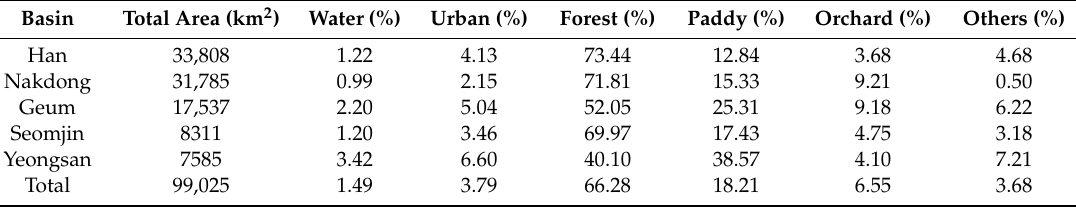
Figure 1. Characteristics of the study area: ( a ) topography of the catchment and locations of 5 major basins, 6 dam sites, and 60 Automated Surface Observing System (ASOS) stations; ( b ) land cover / land use map. (Source: digital elevation map (DEM) and land cover / land use map obtained from WAMIS; location of dams and ASOS stations obtained from KMA). Table 1. Information on land cover / land use in the study catchment.